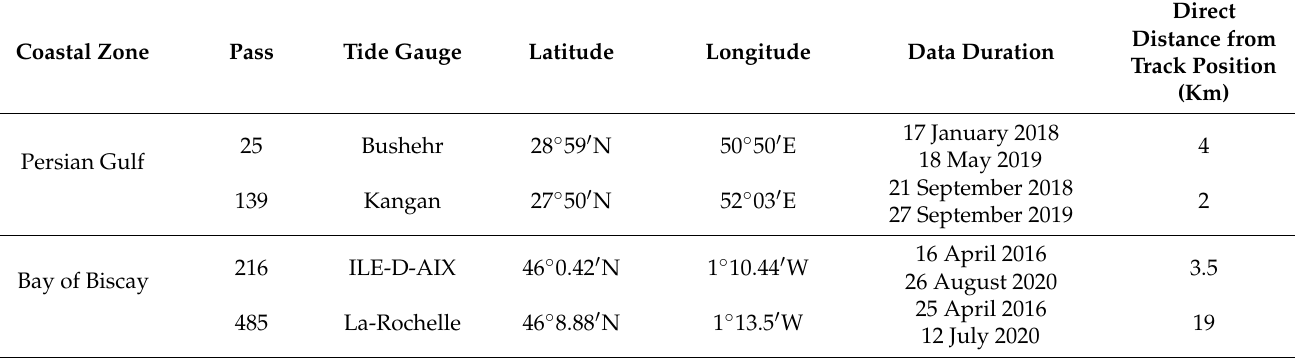
Table 2. Tide gauge stations